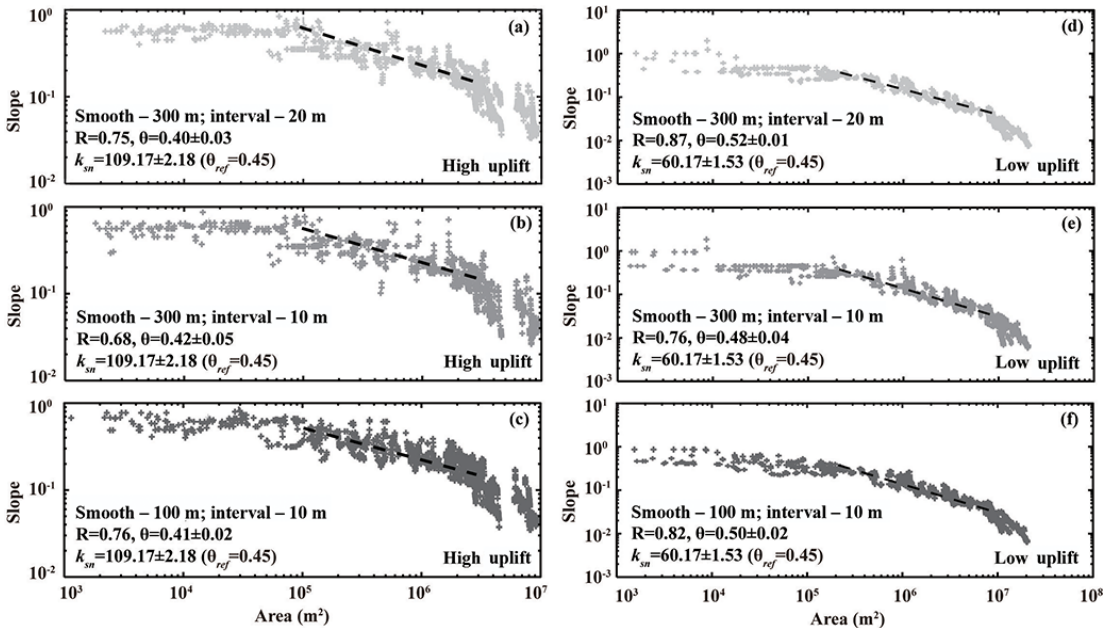
Figure 16. Log-transformed slope–area plots of streams in the high-uplift (a–c) and low-uplift (d–f) zones. Streams within the same zone are composited. The slope data are calculated via different methods: a 300m smoothing window and 20m contour sampling interval (a, d) , a 300m smoothing window and 10m contour sampling interval (b, e) , and a 100m smoothing window and 10m contour sampling interval (c, f) . Elevation data are from 1 / 3arcsec USGS DEM (downloaded from https://catalog.data.gov/dataset/national-elevation-dataset-ned-1-3).